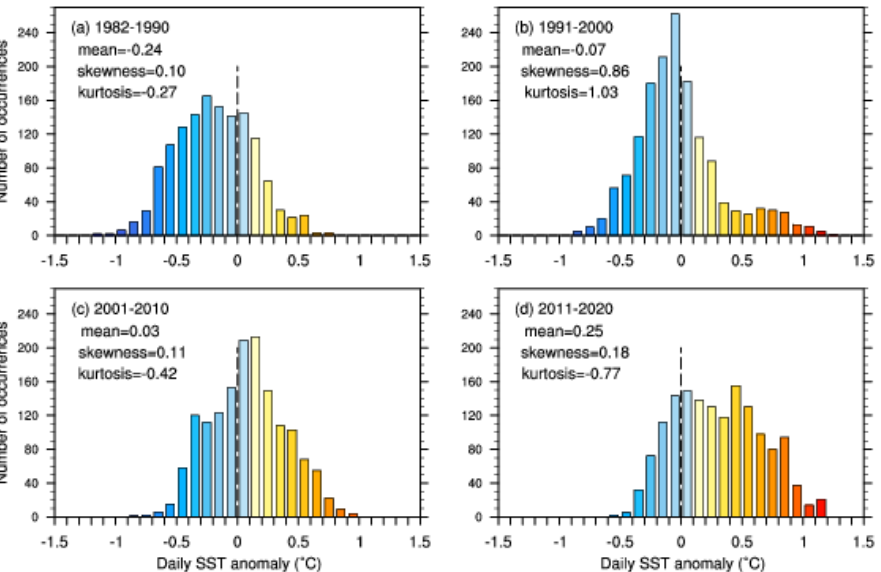
Figure 7. Daily mean SSTAs histograms in the warm season for 1982 – 1990 ( a ), 1991 – 2000 ( b ), 2001 – 2010 ( c ), and 2011 – 2020 ( d ) in the SCS. The black dashed line represents SSTAs equal to 0 °C. Anomalies are measured in comparison to the 1983 – 2012 average. Statistics related to the location (mean) and shape (skewness and kurtosis) parameters are also shown here.